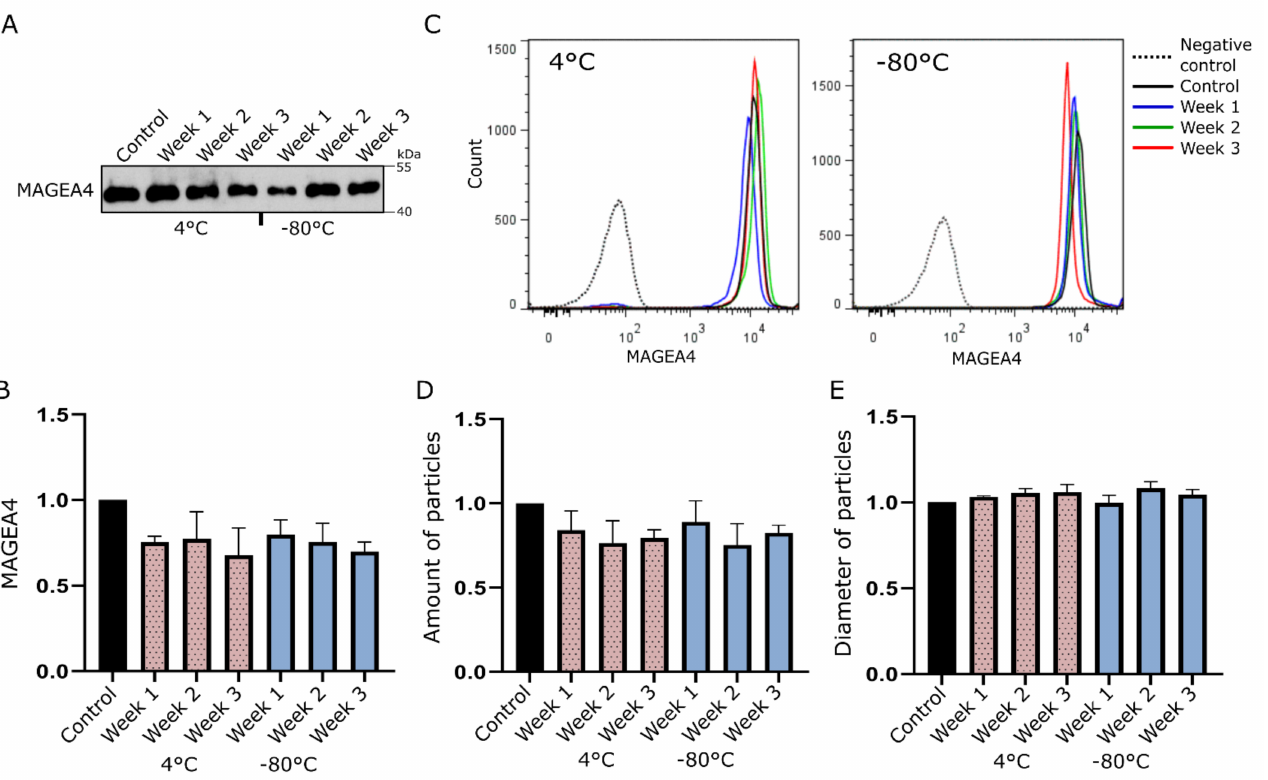
Figure 1. MAGEA4 carrying extracellular vesicles (MAGEA4-EVs) are stable under common EV storage conditions. MAGEA4- EVs were incubated at − 80 ◦ C or 4 ◦ C for up to 3 weeks, and a sample from each group was analyzed after every 7 days. ( A ) Western blot analysis of MAGEA4-EVs at different time points with antibodies against the MAGEA4 protein. ( B , C ) The relative surface binding of MAGEA4 analyzed by flow cytometry using anti-MAGEA4 and Alexa 488-conjugated secondary antibodies. The relative mean fluorescence intensity (MFI) values ( B ) of an average of three experiments and fluorescence profiles ( C ) of a representative experiment are shown. ( D ) The amount and ( E ) average diameter of vesicles as measured by the nanoparticle tracking analysis (NTA). Data shown are average of three independent experiments. In all cases, the relative values, where the control was set as 1, are shown. Freshly prepared MAGEA4-EVs serve as a negative